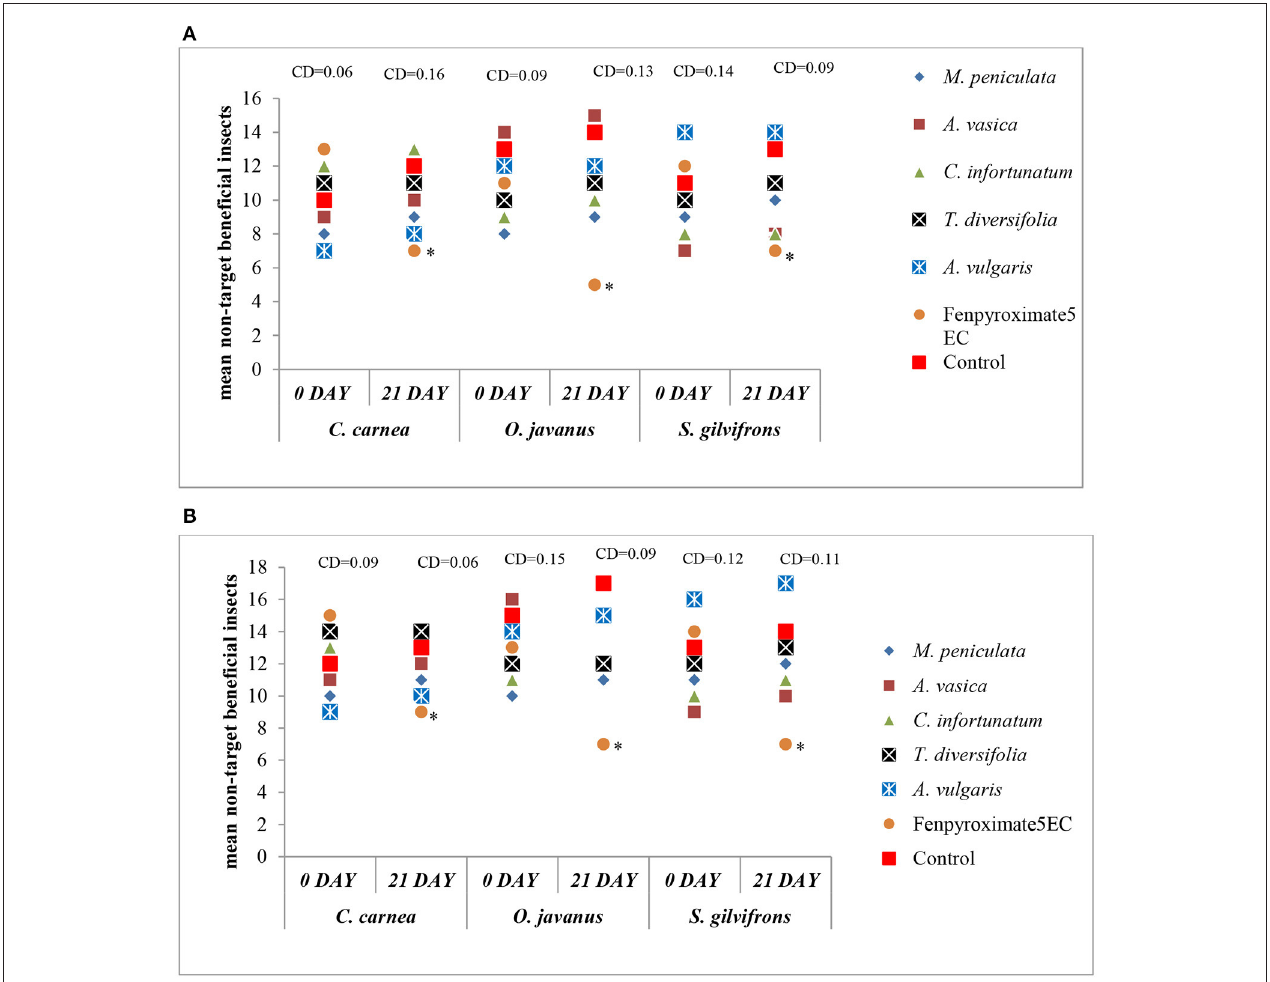
FIGURE 3 | Effect of aqueous extracts of selected plants on non-target beneficial organisms before treatment (0 day) and after 21 days. (A) during season-I and (B) during season-II. *Values are significantly different between day 1 and 21 by t -test ( p <